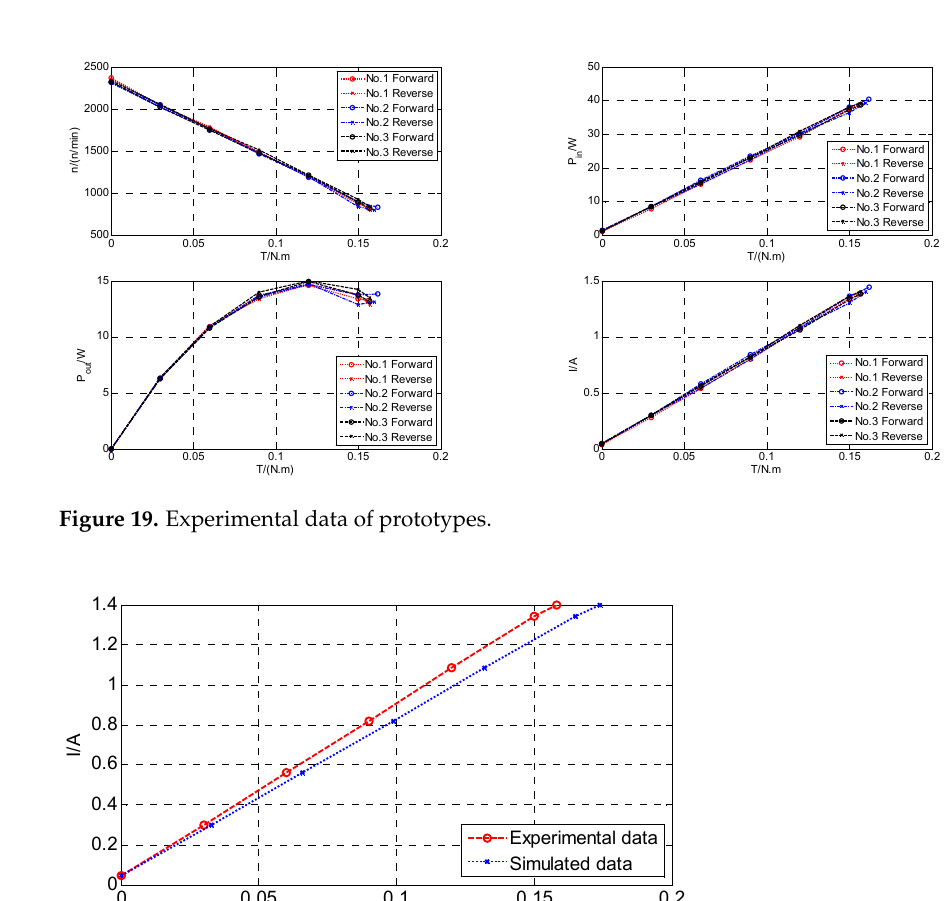
Figure 18. Photos of the experiment: ( a ) prototypes; ( b ) experimental hardware platform.